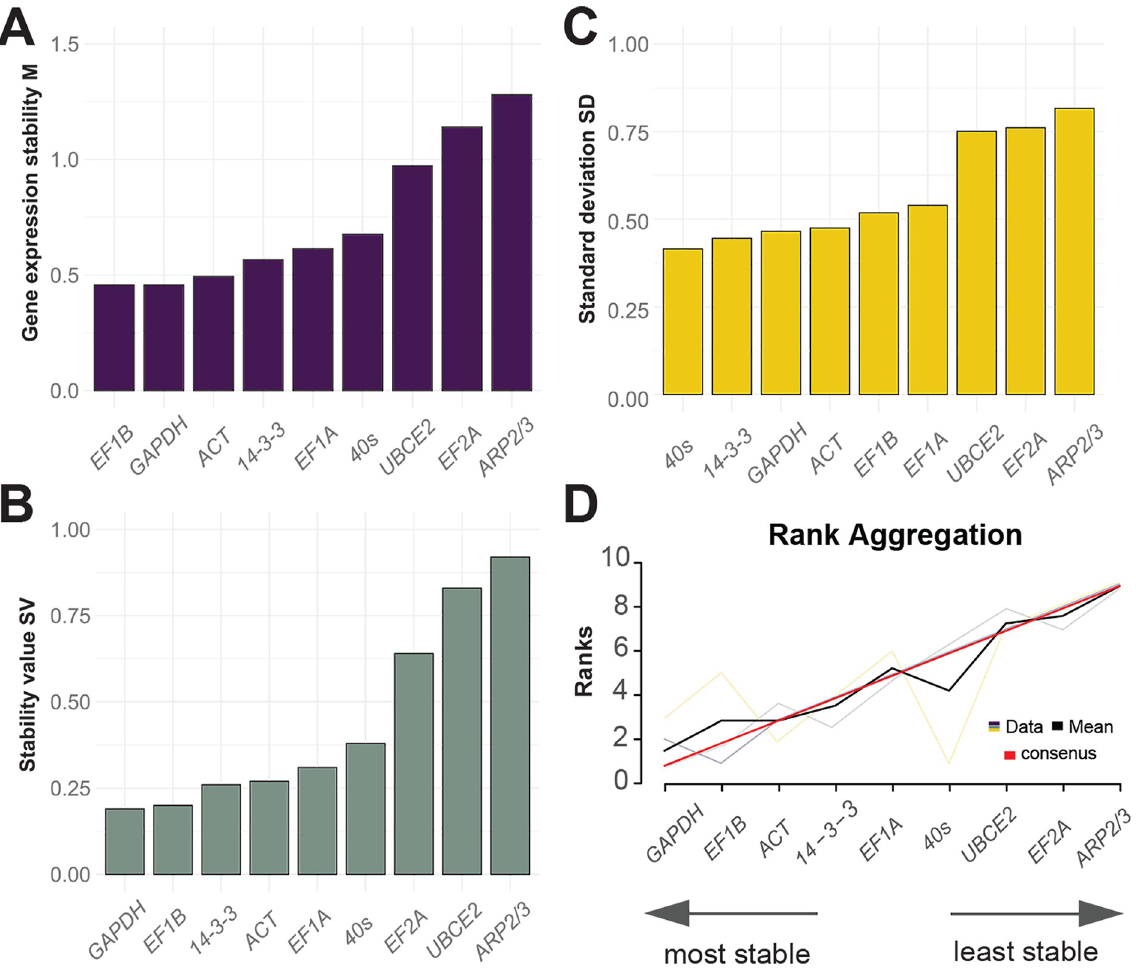
Fig 2. Individual ranking of housekeeping genes by stability. Stability values for nine candidate reference genes generated by the following algorithms: A) geNorm, B) NormFinder, C) BestKeeper, and D) a consensus (by rank aggregation). The maxiumum scale for A-C represent the maximum acceptability value for each stability